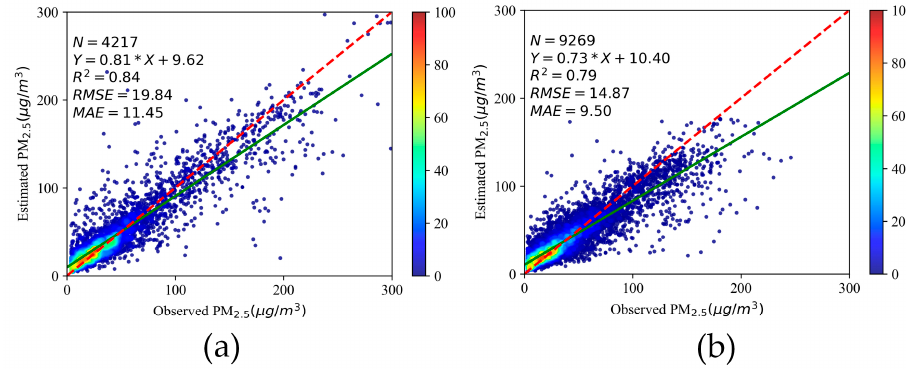
Figure 8. Scatterplots of the RF model with 10-fold, cross-validation of model accuracy. Data with ( a ) moon phase angle > 120° and with ( b ) moon phase angle ≤ 120°. Red dashed line, 1:1 line; solid green line, fitted line.